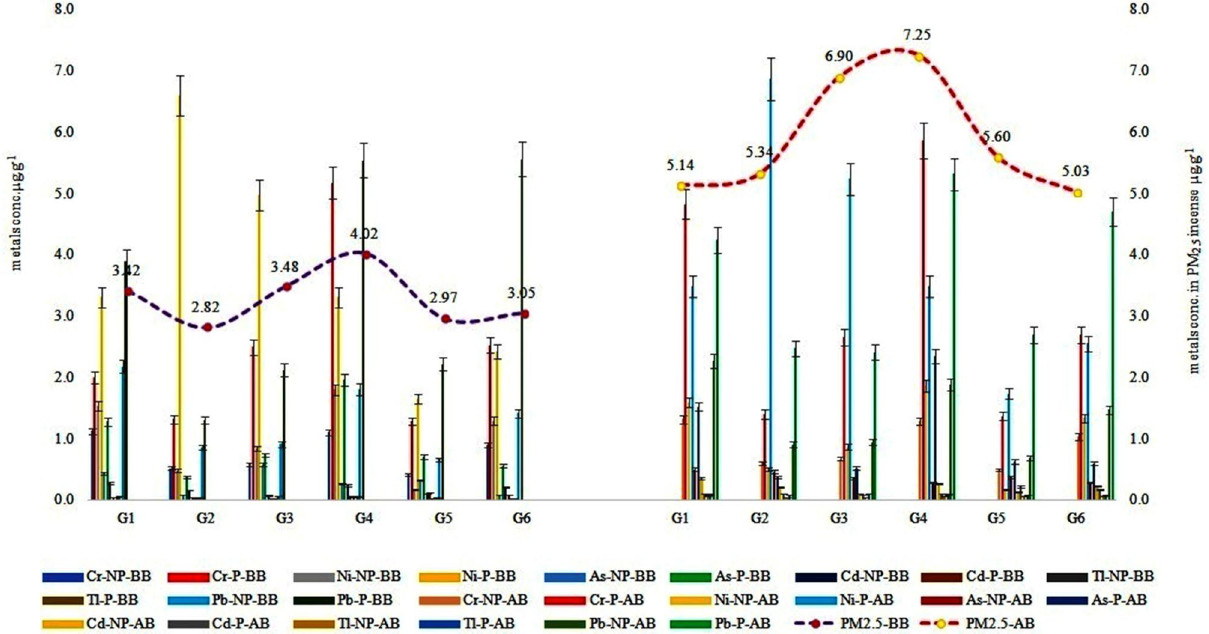
Figure 3. Trace metals and Governorate-wise before and after burning non-perfumed and perfumed incense. G1–G6 Kuwait Governorates; NP non-perfumed incense, P perfumed incense; BB before burning; AB after